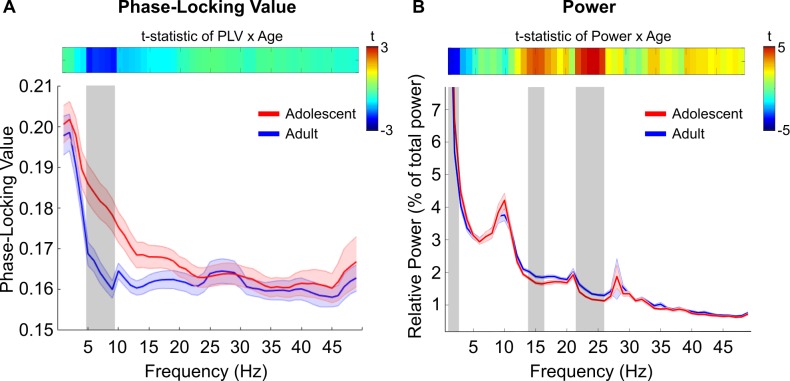
Developmental differences in global cortical phase-locking and power.(A) Across most frequency bands, adolescents displayed similar resting-state phase-locking to adults. However, in the 5–9 Hz frequency band, there was a significant linear decrease in phase-locking throughout development (gray shaded region; p < 0.05, FDR corrected). Top color bar represents the magnitude of the t statistic from the PLV × Age regression model. Data displayed categorically after segregation into 2 groups via a median split. (B) Power as a function of frequency. Delta band power significantly decreased with age, whereas beta band power significantly increased with age. Top color bar represents the magnitude of the t statistic from the Power × Age regression model. Data displayed categorically after segregation into 2 groups via a median split. In both (A) and (B), shaded gray patches represent frequency intervals demonstrating a significant linear relationship with age. Red and blue lines and shaded bars in the line plots represent the mean (solid line) and standard error of the mean (shaded patch around mean), respectively, in adolescents (red) and adults (blue). See S1 Data for individual data points. FDR, false discovery rate; PLV, phase-locking value.